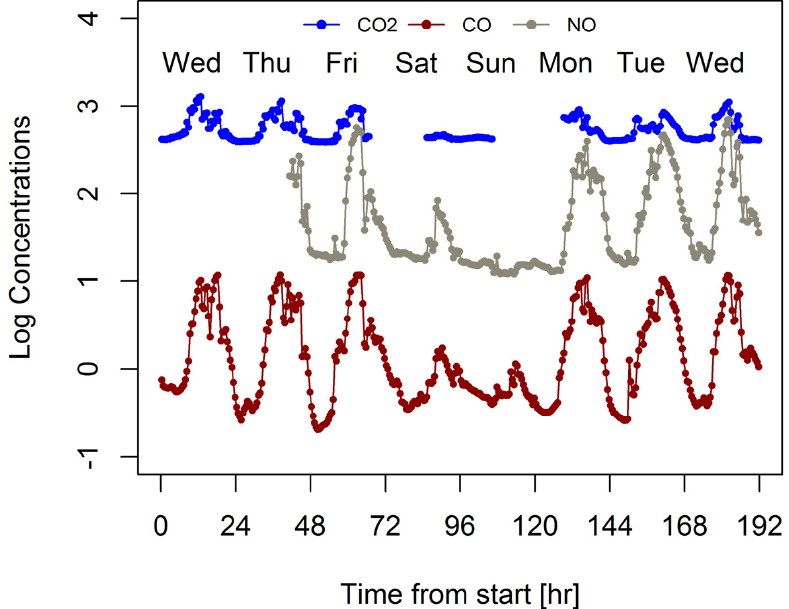
Figure 5. 30 min average CO 2 , NO and CO plotted against time from start of test.